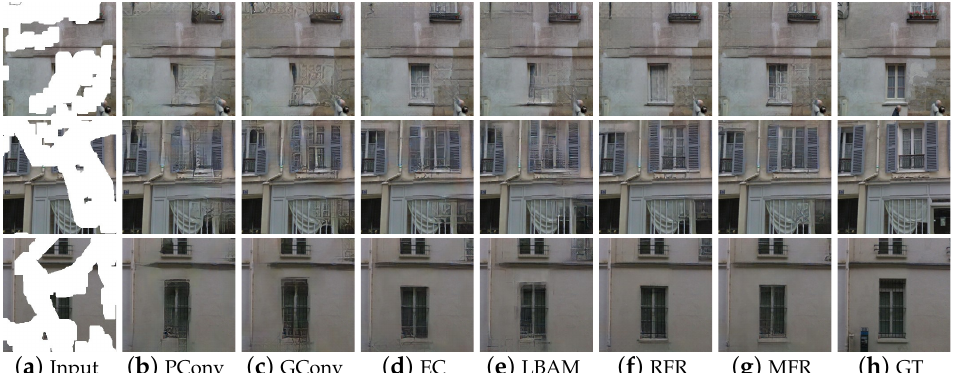
Figure 6. Qualitative comparison on Paris